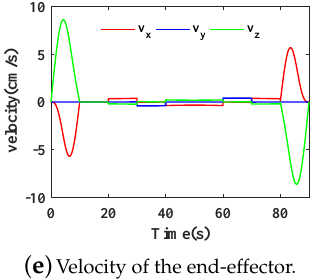
Figure 14. Experiment result of SET2 in the underwater environment.